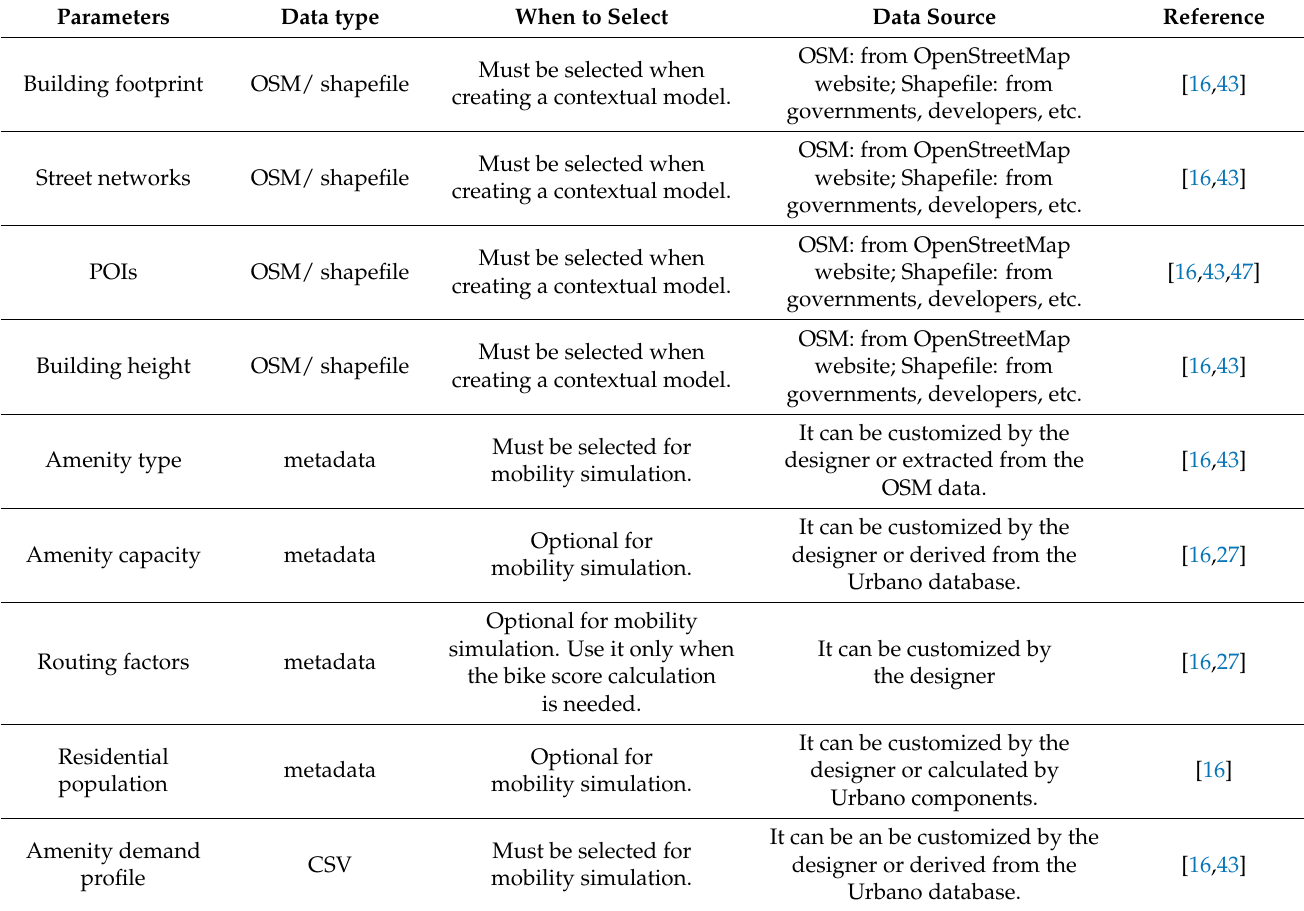
Table 2. The details of input parameters of context modeling and